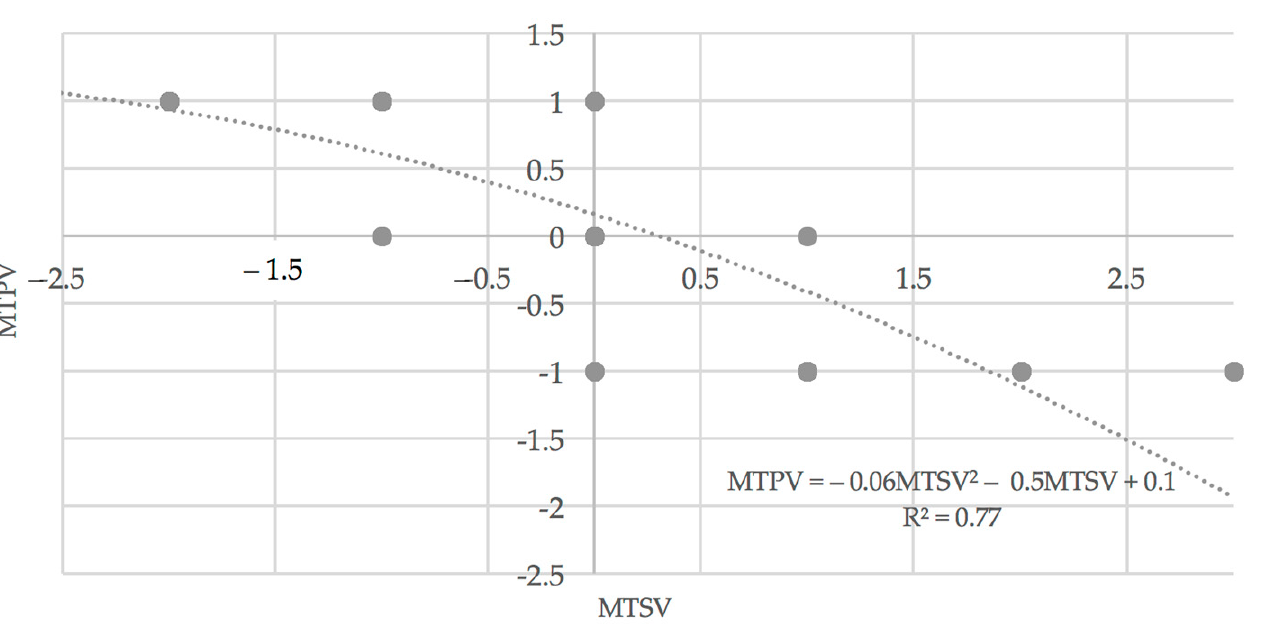
desire for higher air temperature.